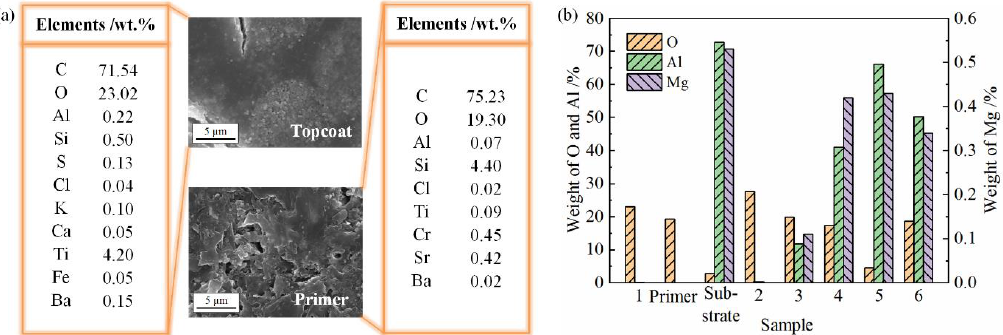
Figure 5. Chemical composition measurement results of sample surfaces obtained by EDS: ( a ) measurement results of chemical elements for topcoat and primer, ( b ) main characteristic chemical components of the observed samples.